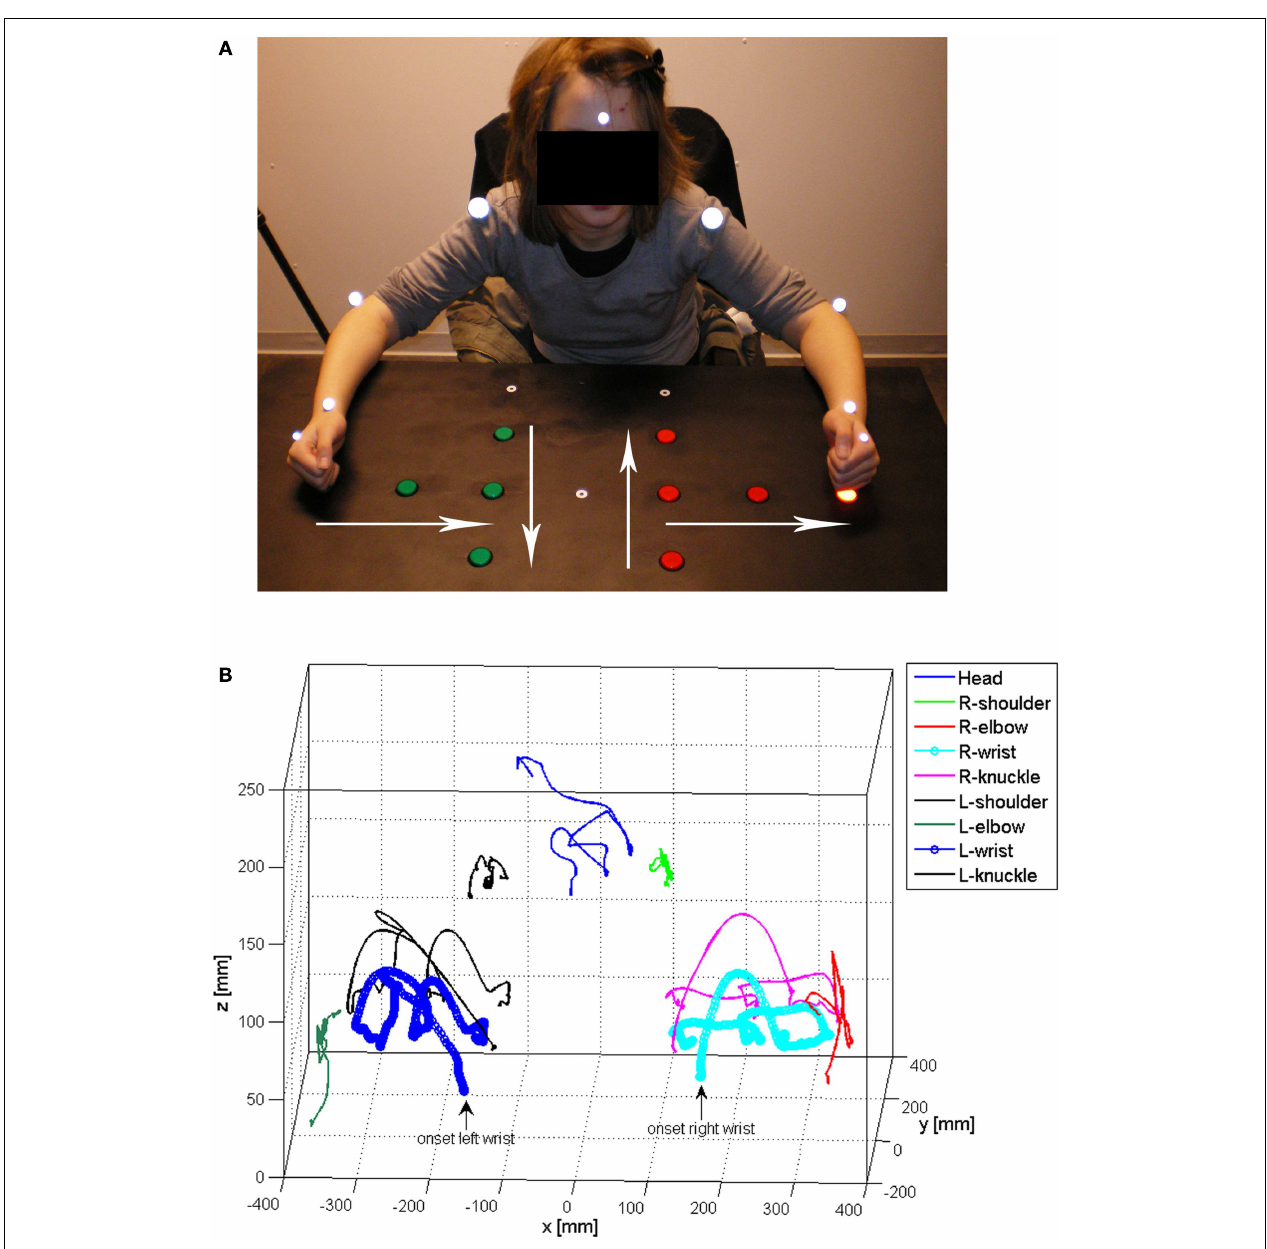
FIGURE 1 | Photo illustrating the experiment condition and the marker set-up (A), and an example of 3D movement registration (displacement of the corresponding markers) during (bimanual) light-switch task performance (pressing three light-switch buttons in a sequential,